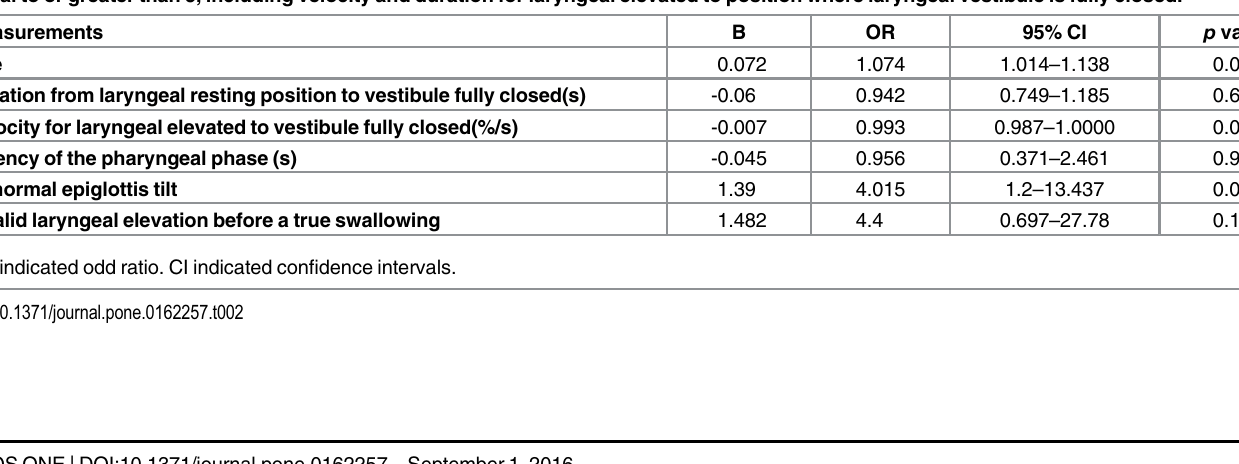
Table 2. Results from the logistic regression analysis of VFS indices identified from previous univariate analysis and their association with PAS equal to or greater than 5, including velocity and duration for laryngeal elevated to position where laryngeal vestibule is fully closed. Measurements